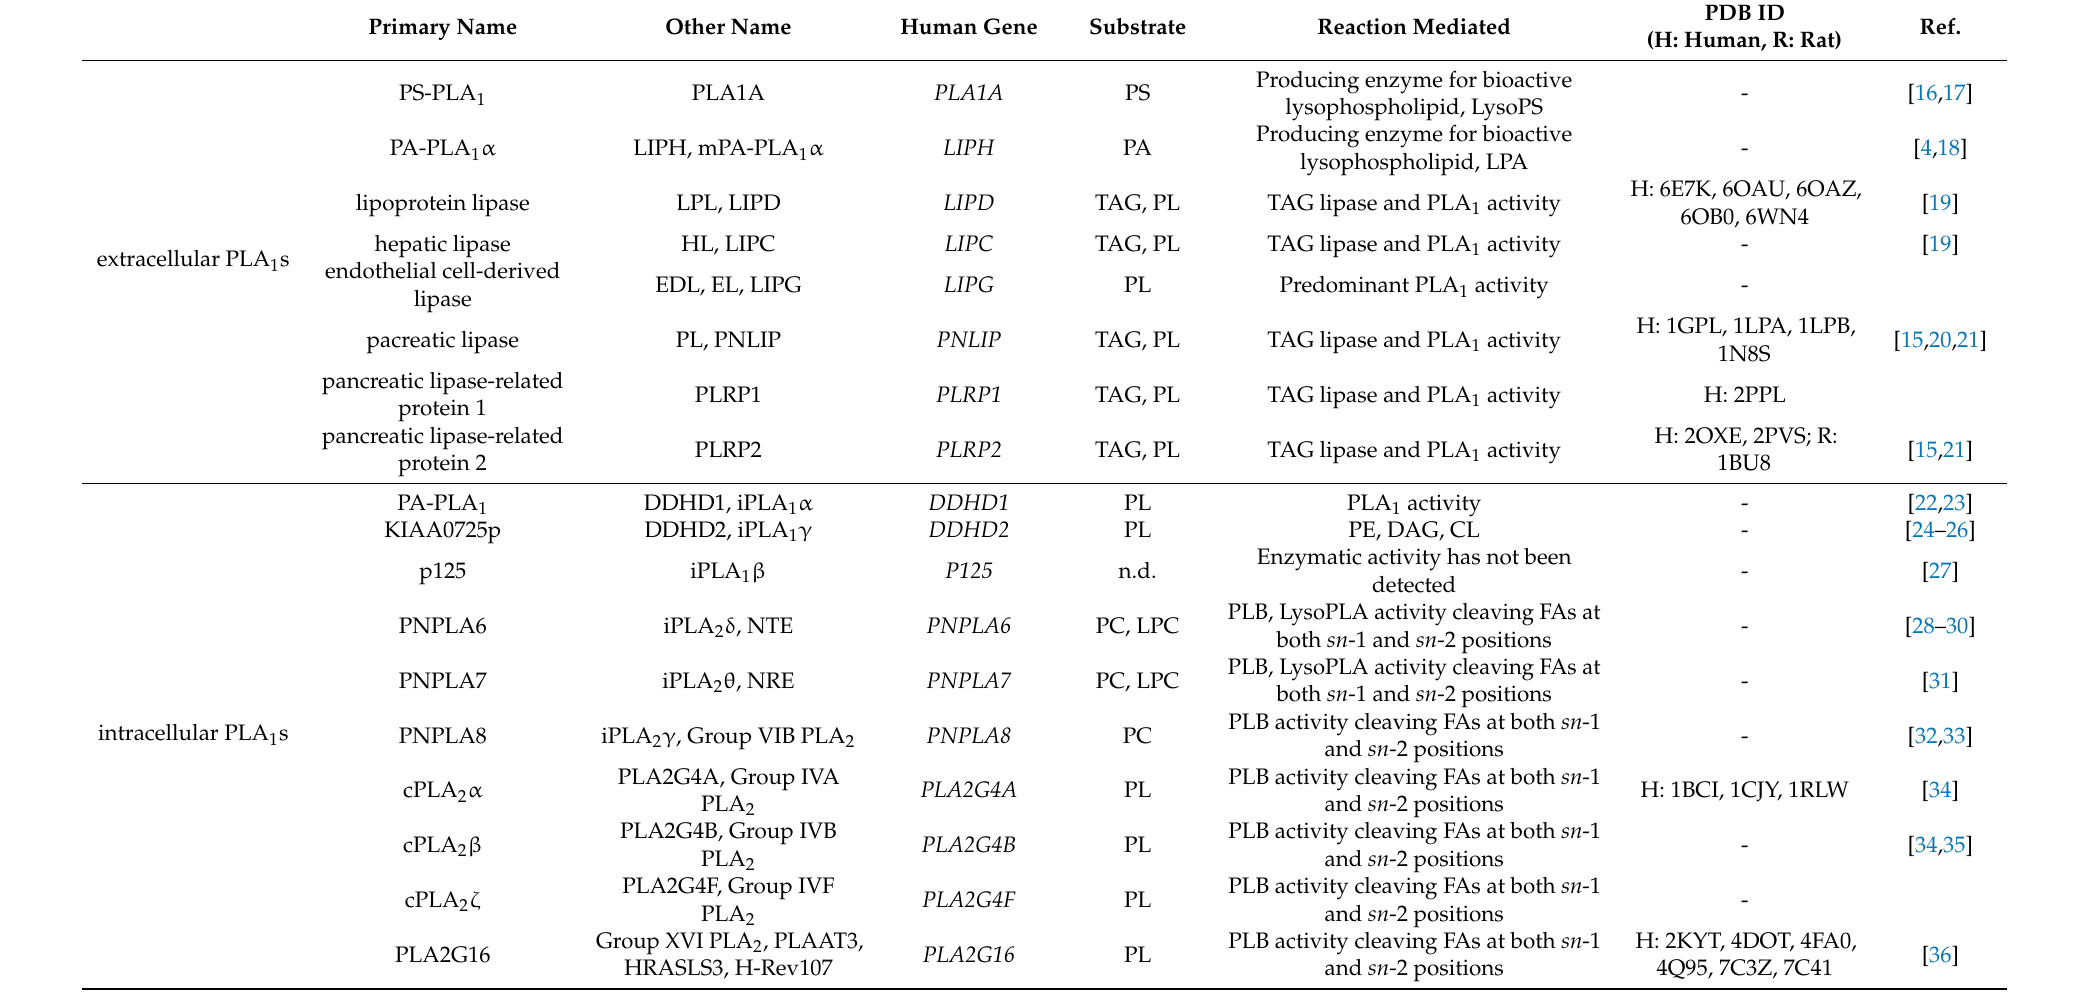
Table 1. Mammalian PLA 1